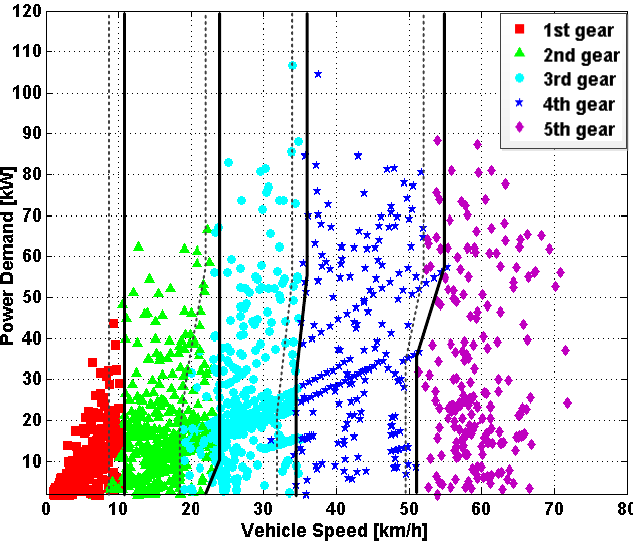
Figure 10. AMT gear-shifting correction.